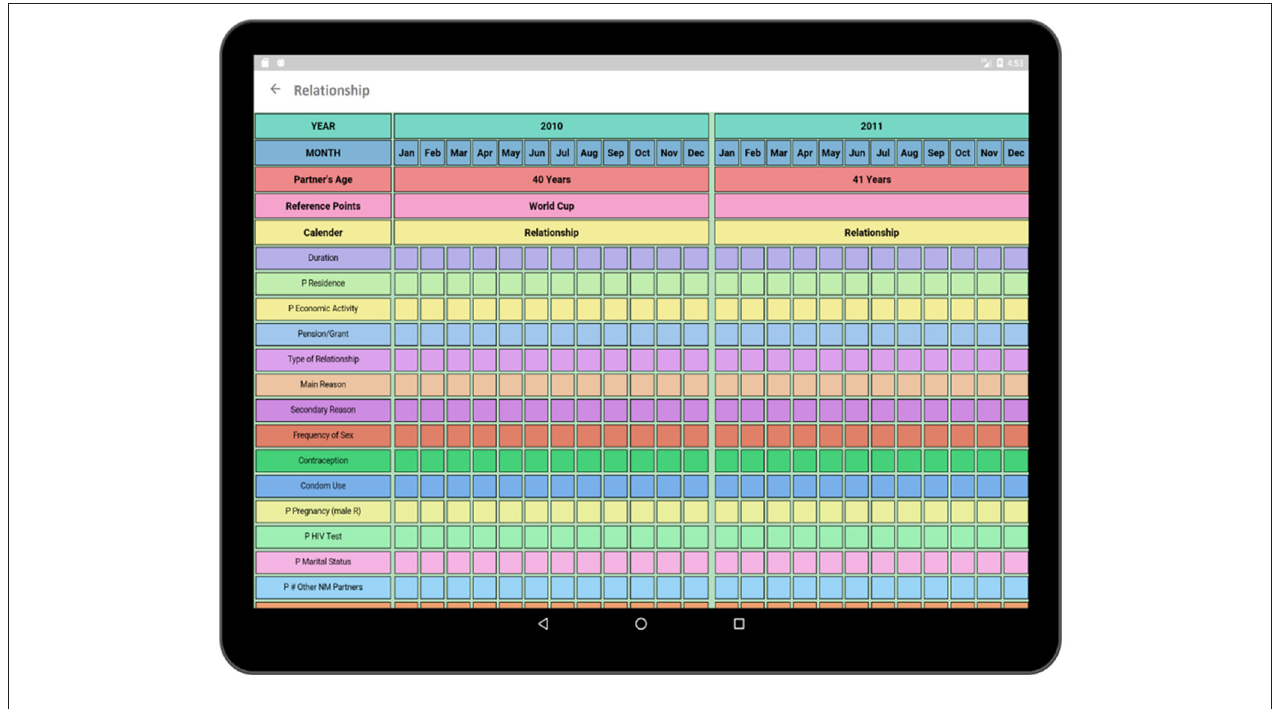
FIGURE 13 | Add relationship (calendar view).